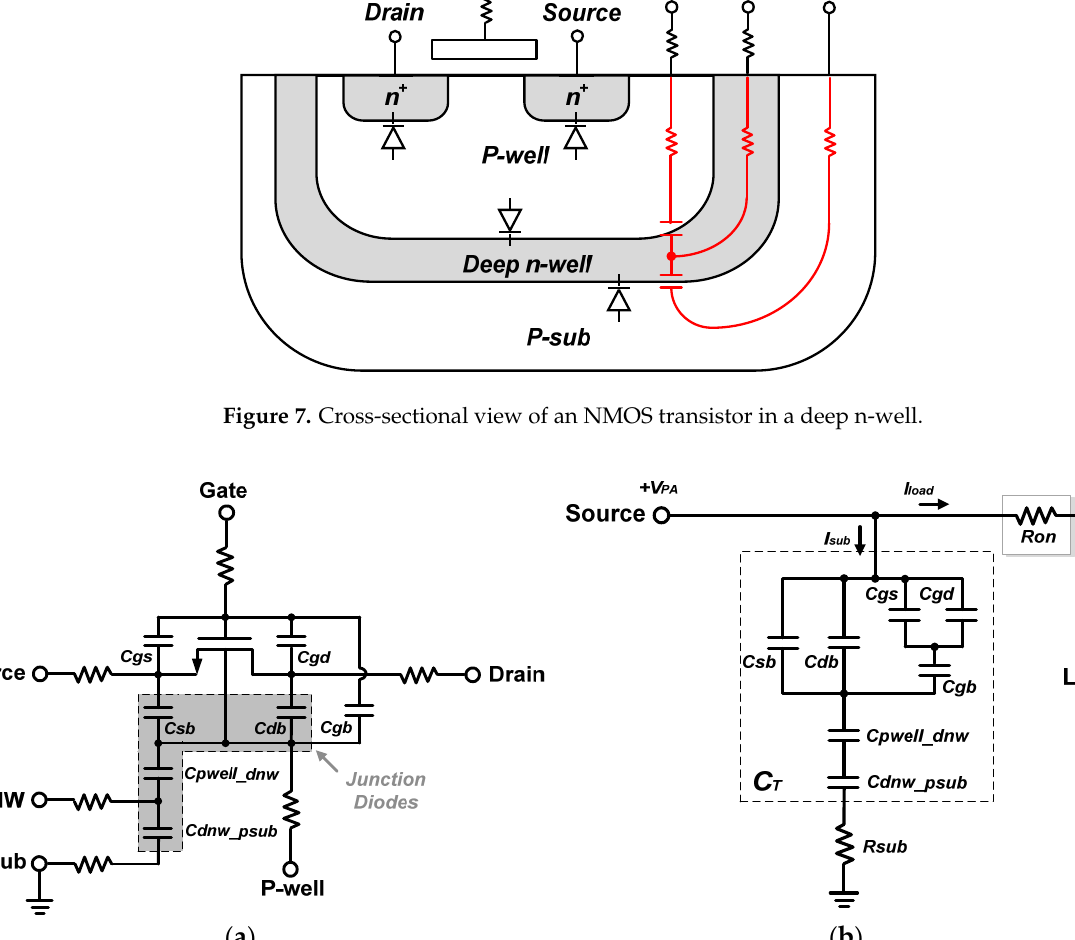
Figure 7. Cross-sectional view of an NMOS transistor in a deep n-well.